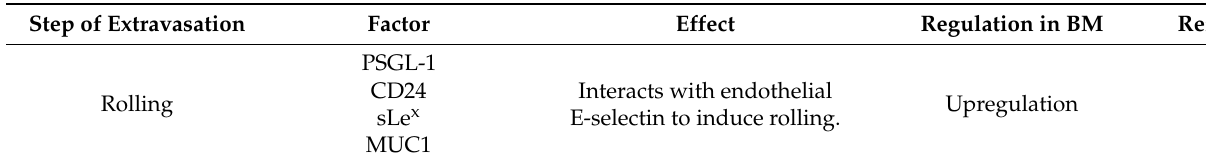
Table 1. Factors that mediate extravasation during breast cancer brain